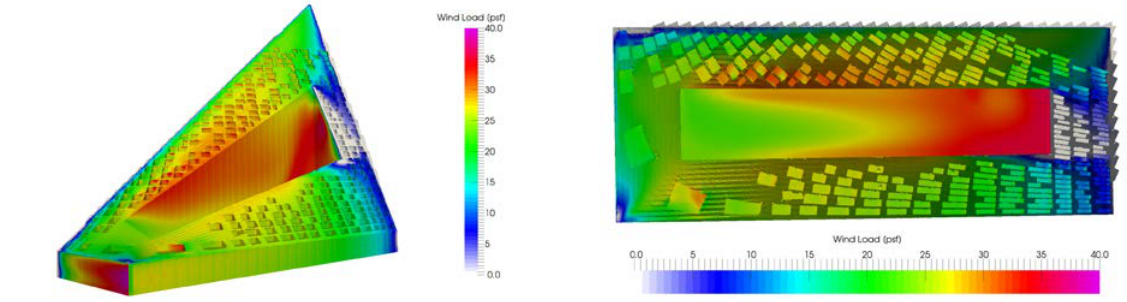
Fig. 8 3D fringe plots indicate positive pressure loads calculated from a single wind direction.